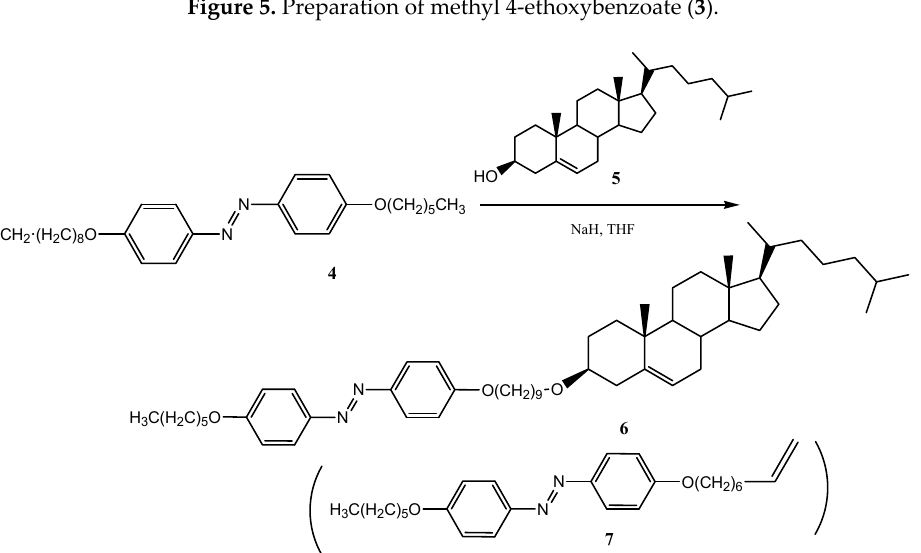
Figure 5. Preparation of methyl 4-ethoxybenzoate ( 3 ).